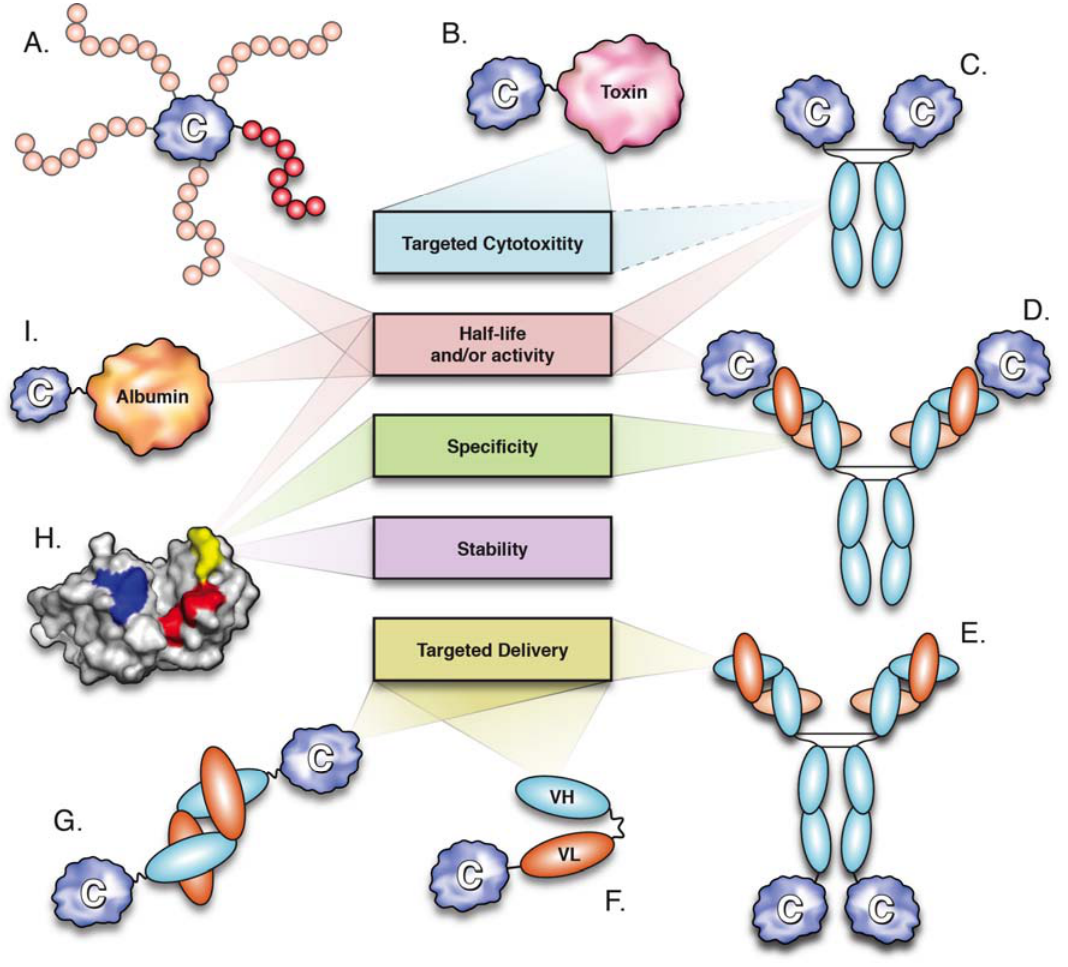
Figure 1. Molecular engineering strategies utilized for cytokine optimization and their major effects. ( A ) PEGylation (positional isomers displayed); ( B ) cytokine-toxin fusion; ( C ) cytokine-Fc fusion; ( D ) antibody-cytokine immune complex; ( E – G ) immunocytokines; ( E ) cytokine-IgG; ( F ) cytokine-scFv; cytokine-diabody; ( H ) cytokine mutagenesis; ( I ) cytokine-albumin